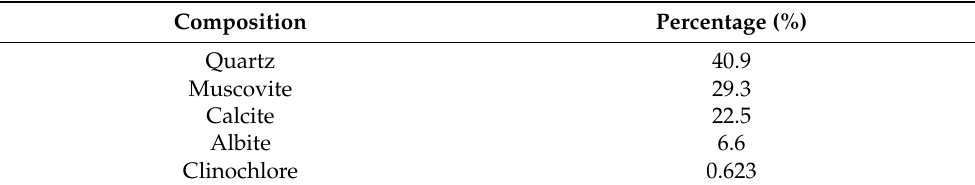
Table 3. Compositions of clay minerals.